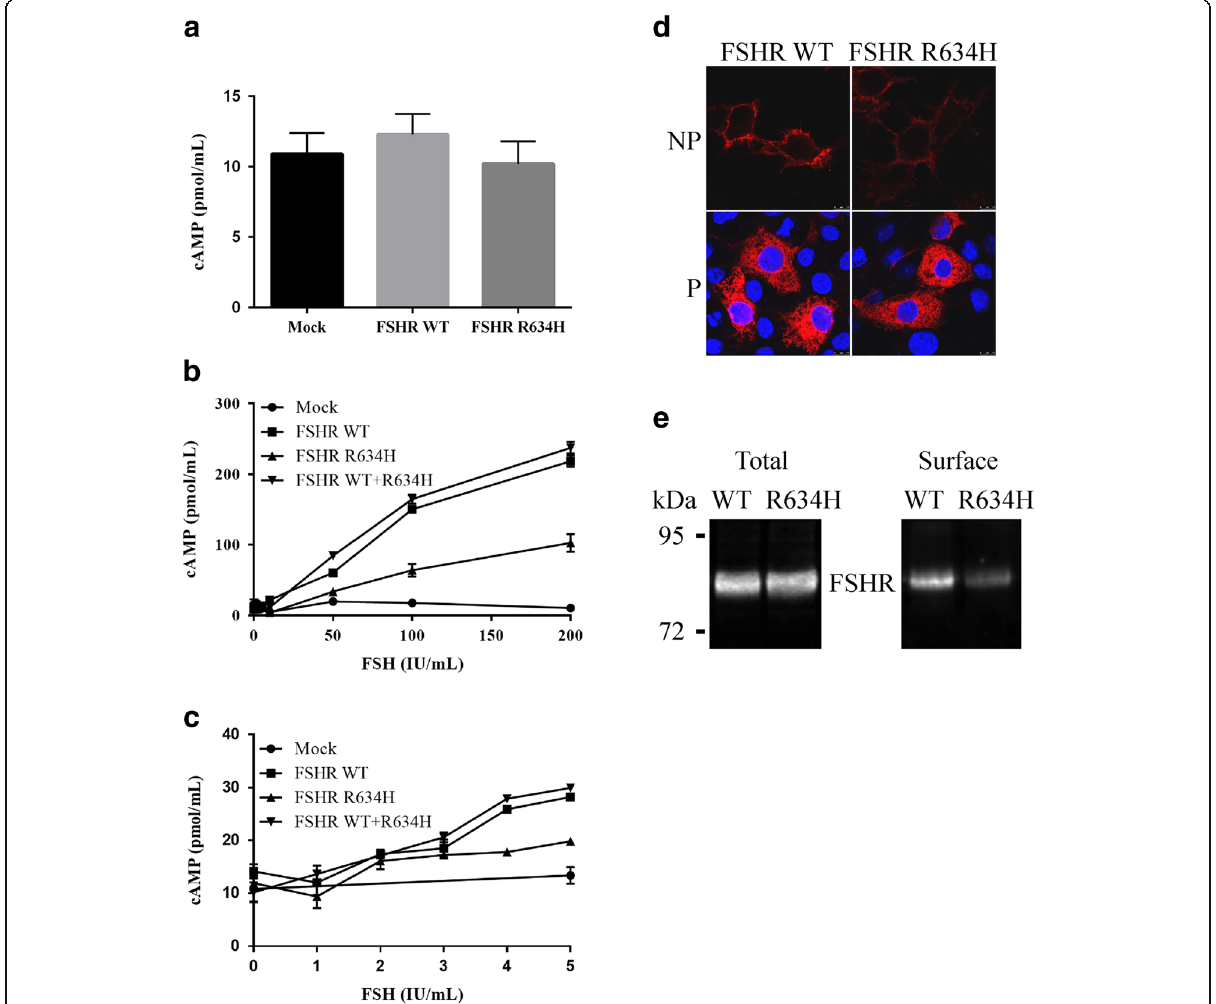
Fig. 3 Functional studies of the wild-type and mutant FSHR. COS-7 cells were transfected with empty (mock) or expression vector encoding WT and/or mutated receptor. a Cyclic AMP (cAMP) level observed in transfected cells in the absence of any hormonal stimulation. Graph represents the results of at least three separate experiments performed in duplicate conditions. b and c Transfected cells were incubated with increasing concentrations of human follicle-stimulating hormone (FSH) and the accumulation of cAMP was measured. Each graph represents the results (mean±SEM) of at least two separate experiments. d Cell surface expression of WT and mutated FSHRs. Permeabilized (P) or nonpermeabilized (NP) transfected cells were incubated with the FSHR323 antibody. Confocal microscopy was used to study the cellular distribution of receptors. e The membrane expression of the FSHR R634H is decreased. COS-7 cells were transfected with WT or mutated FSHR. Immunoprecipitation of FSHR from total extract (total) or from cell surface (surface) was performed using FSHR323. Immunoprecipitated FSHR was analyzed by western-blotting. Size of the molecular mass is